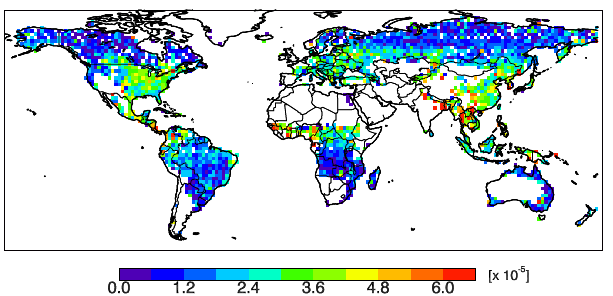
Fig. 9. Derived monthly averages for instantaneous fluorescence yield, Φ , (unitless) for July 2009 from the GOSAT P polarization.